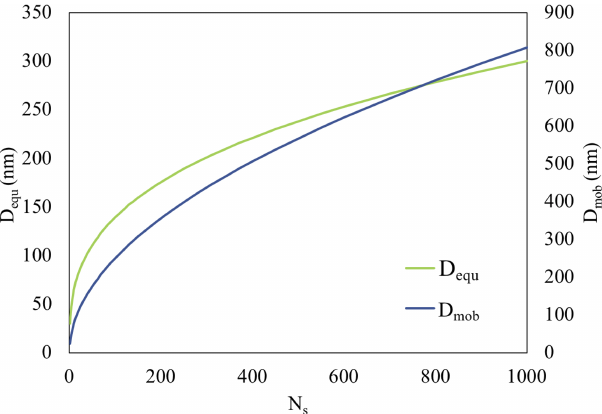
Figure 2. Examples of black carbon fractal aggregates (BCFAs) with 200 primary particles and varying D f and f organics .